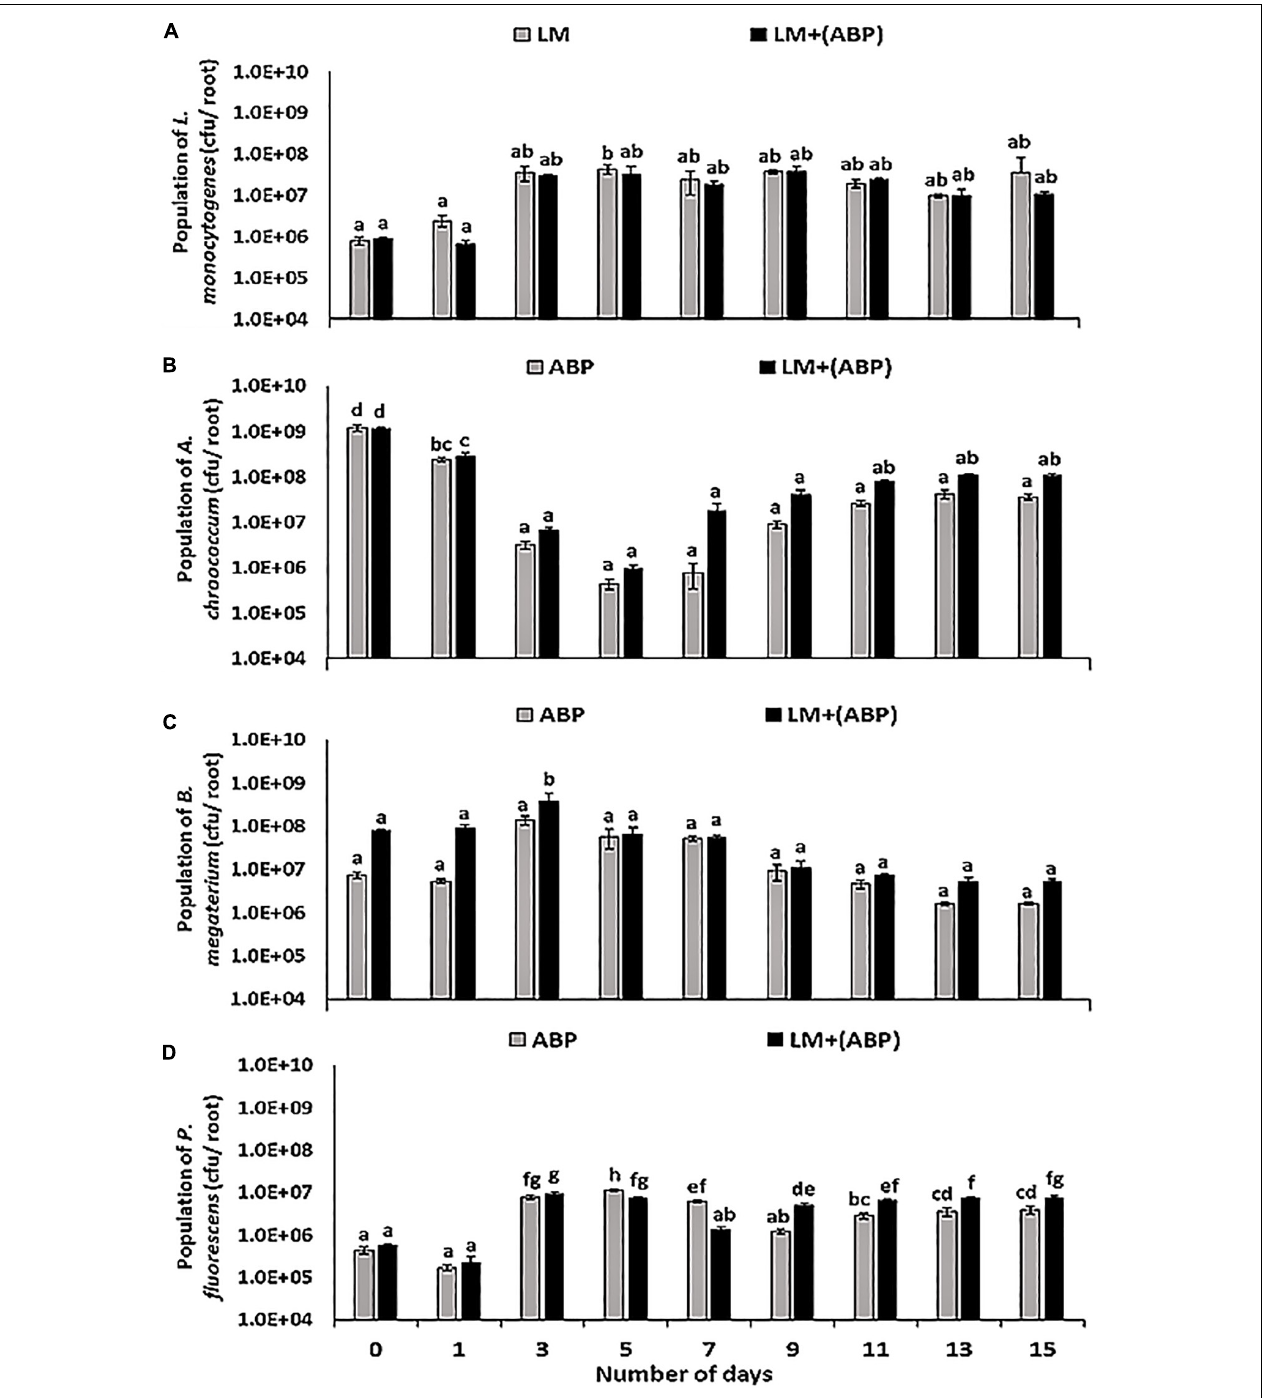
FIGURE 2 | Population dynamics of (A) L. monocytogenes , (B) A. chroococcum , (C) B. megaterium , and (D) P. fluorescens during incubation in the F. arundinacea plant model for 15 days, assayed by plating samples on TSA containing rifampicin, streptomycin, kanamycin and ampicillin, respectively. Significantly different values ( p < 0.05) between different treatments and time points are marked by lower case letters. Standard deviation ( n = 3) is represented by error bars.